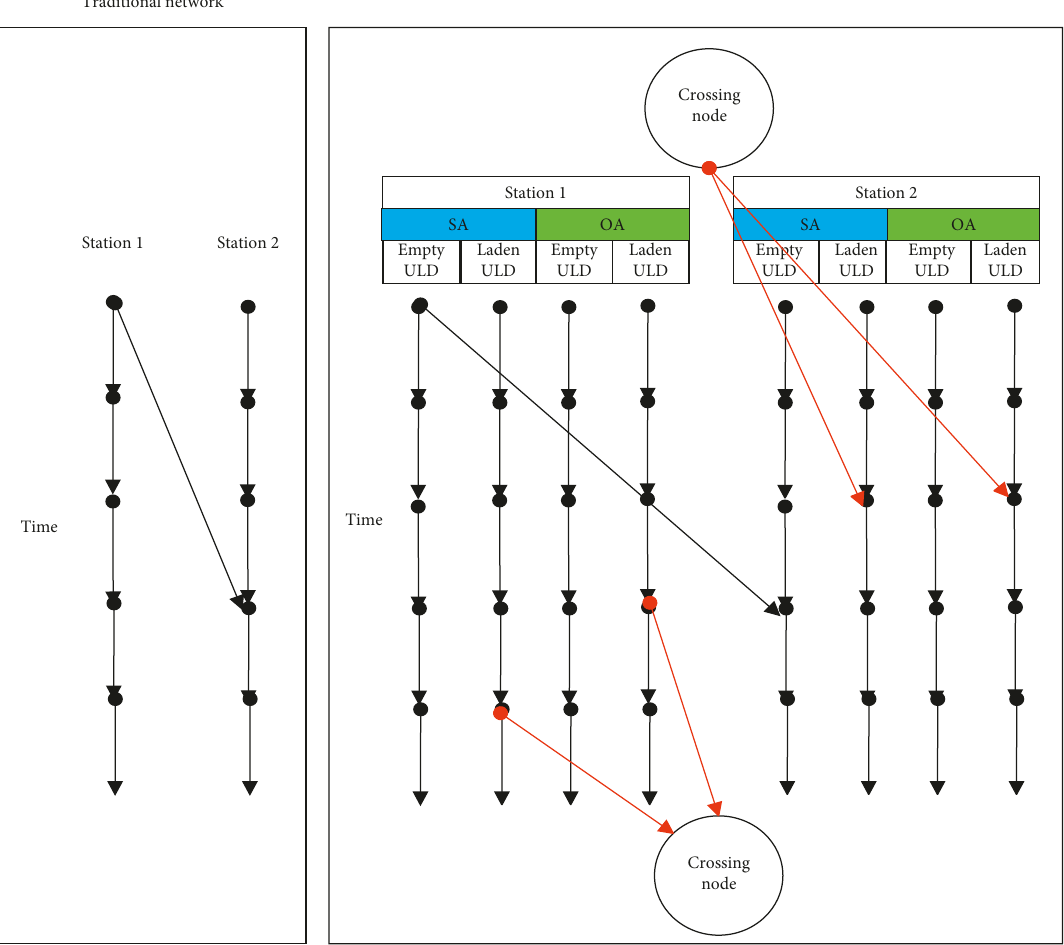
Figure 6: A comparison between traditional and our